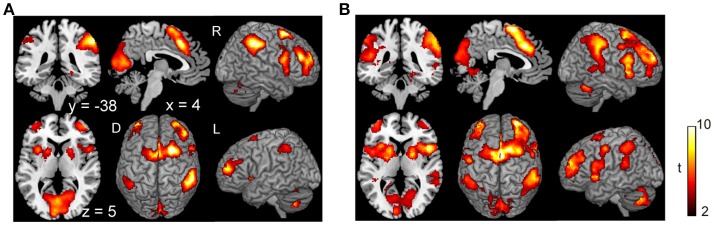
Comparison of the brain activity before the execution of inhibition between voluntary and forced conditions. Activations in the planning phase of an ongoing action task while tapping (A) and while waiting (B) are shown. The color on the brain images indicates the significant difference between the voluntary and forced conditions (self-initiated > stimuli-triggered). Thresholds of activation height and extent were set at the P < 0.001 level (uncorrected) and a cluster-level FWE of 0.05, respectively. The scale for t-scores is shown alongside. The number and alphabetic characters indicate the XYZ coordinates in the Montreal Neurological Institute (MNI) space. The letters in the figure indicate the direction of each brain image (L, left; R, right; D, dorsal).